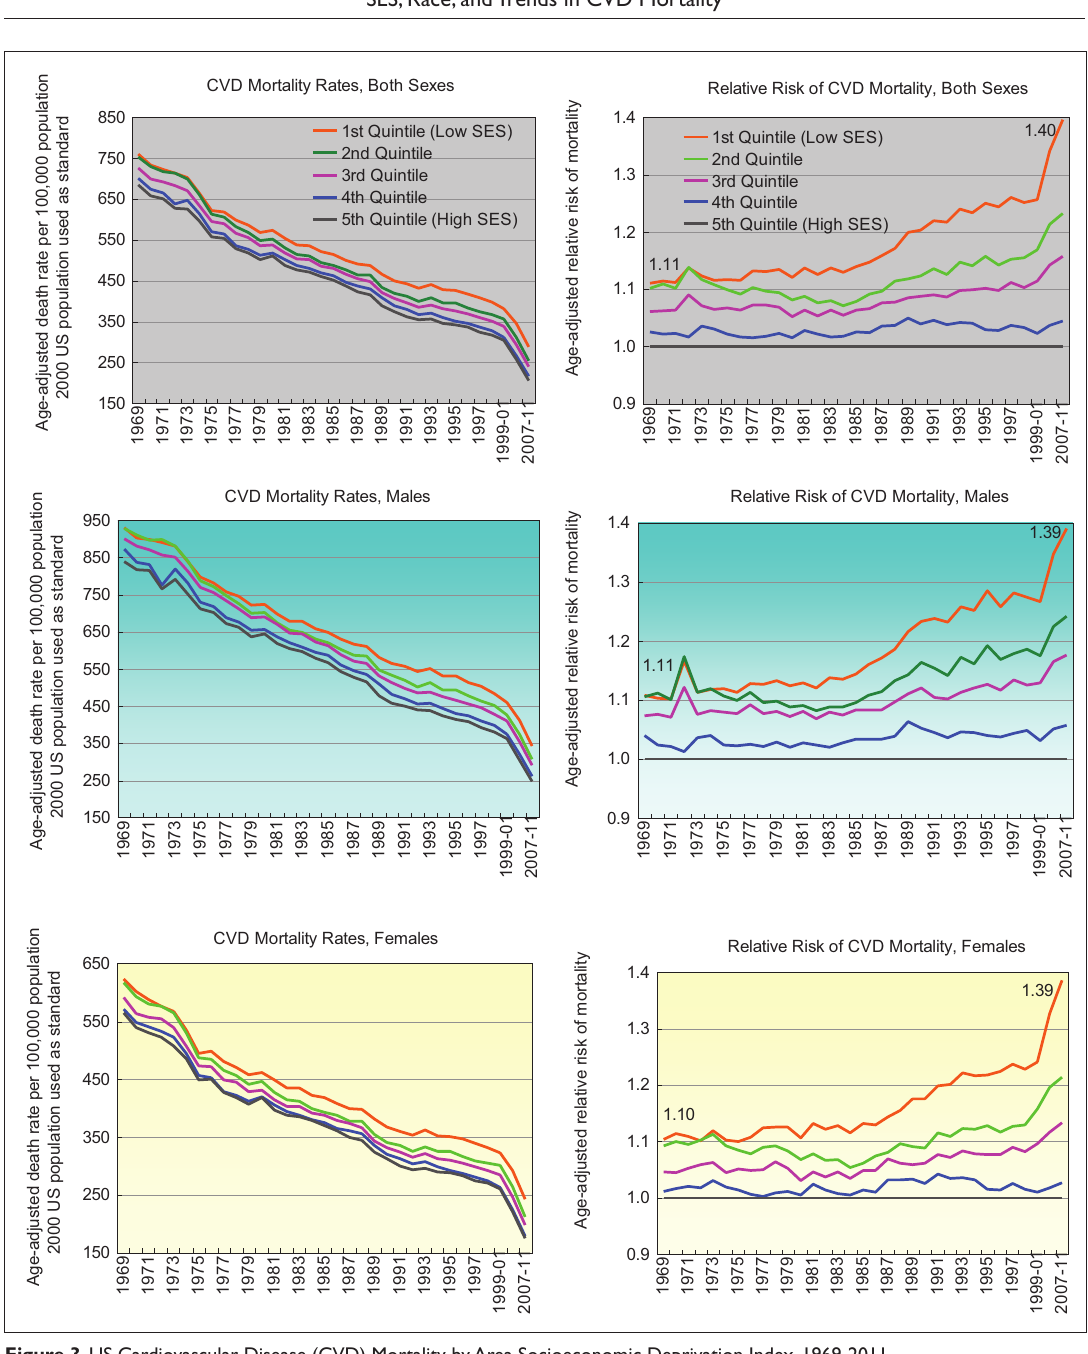
Figure 3 . US Cardiovascular Disease (CVD) Mortality by Area Socioeconomic Deprivation Index,